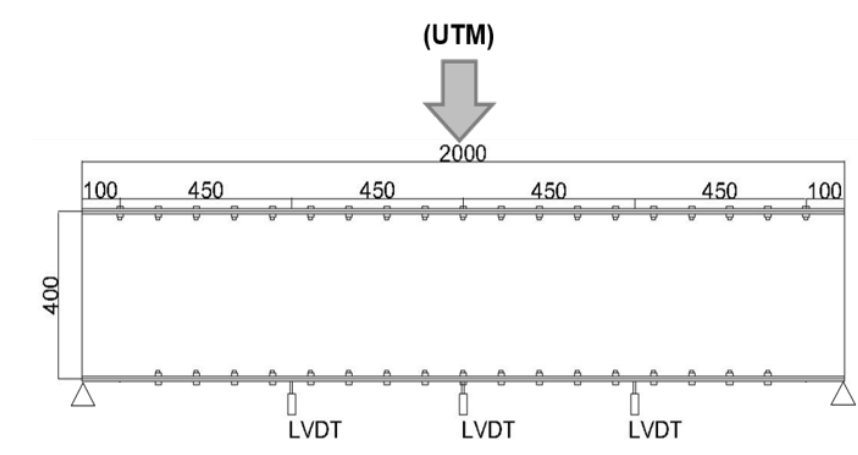
Figure 7. illustration of LVDT sensor’s position.